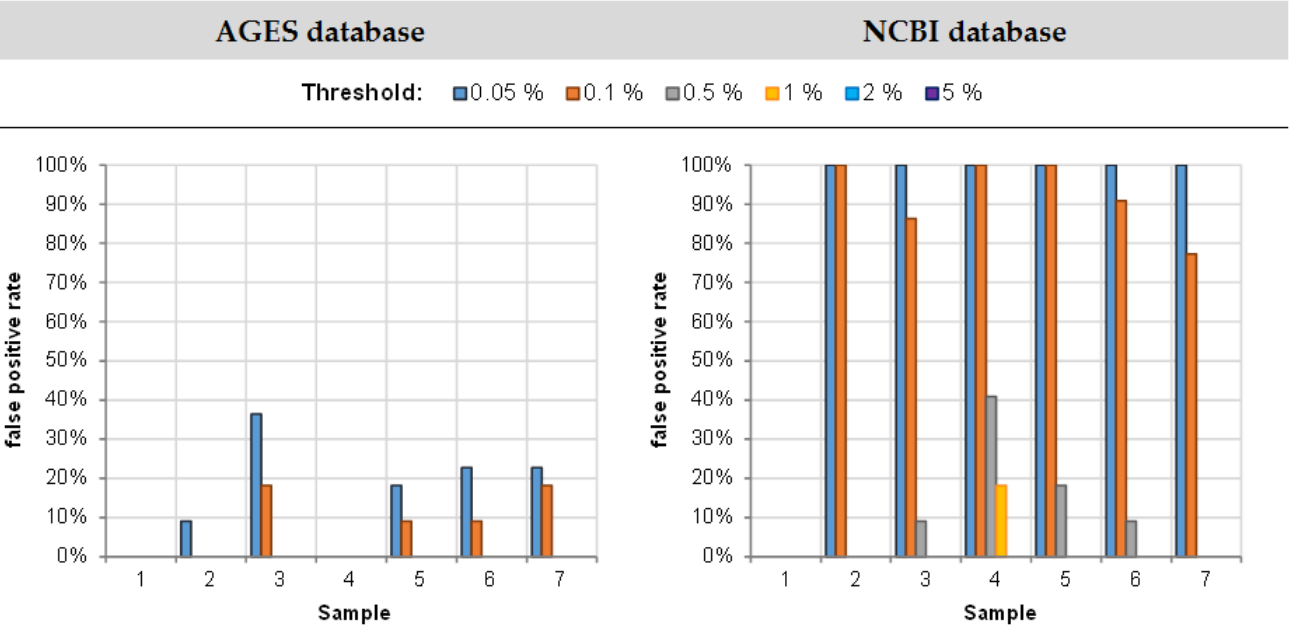
Table 7. Proportion of results below a thresholds of 0.05%, 0.1%, 0.5%, and 1%.